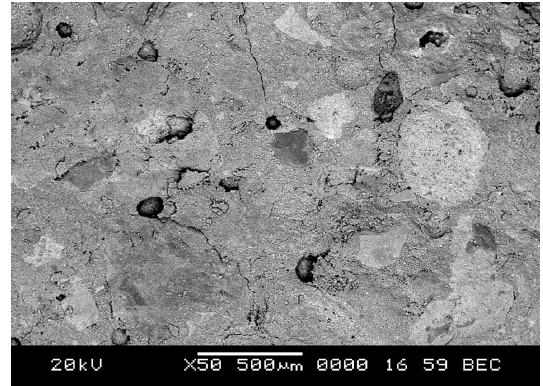
Fig. 8. SEM micrograph (backscattered electron image) showing microcracks